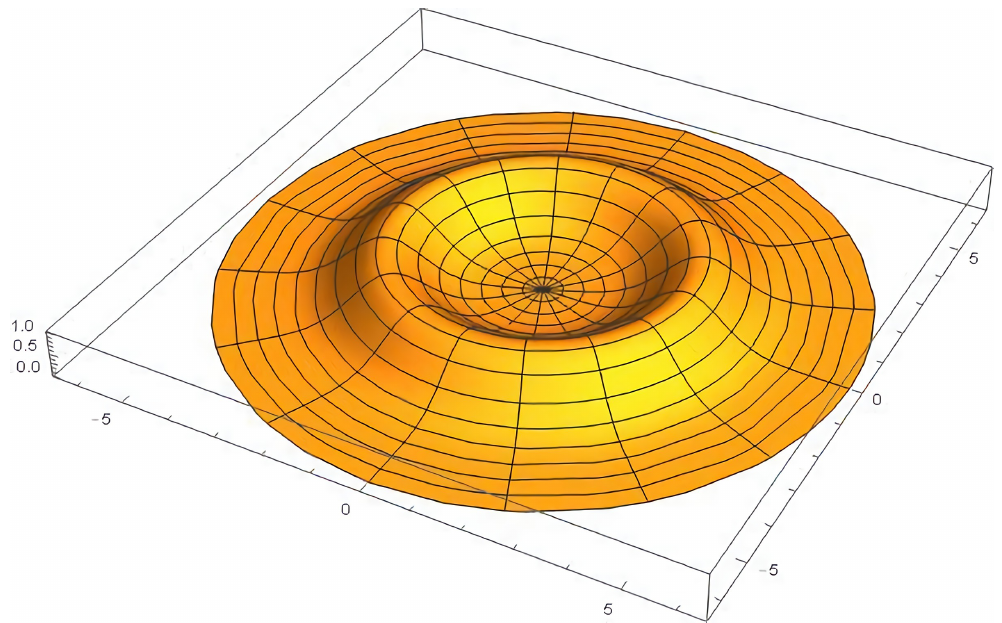
Figure 2. Geometric representation of the manifold on which pseudo-cycles are being considered, visible at sufficiently high energy and identifiable with real cycles. They can be detected by corre- sponding pseudo-homologies defined on the region of high energy. They decay as time increases and the energy decreases, i.e., when the distortion of the underlying manifold becomes